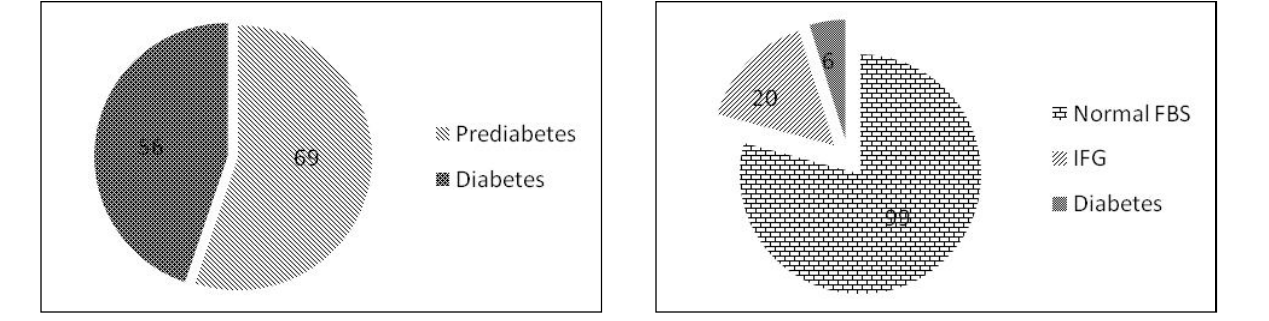
Figure 1. Number of patients with pre-diabetes and diabetes according to HbA1c